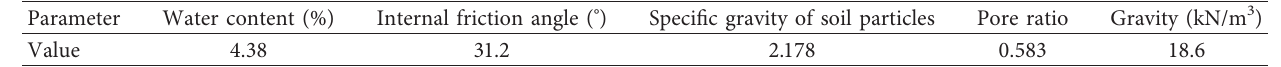
Table 1: Physical and mechanical parameters of the